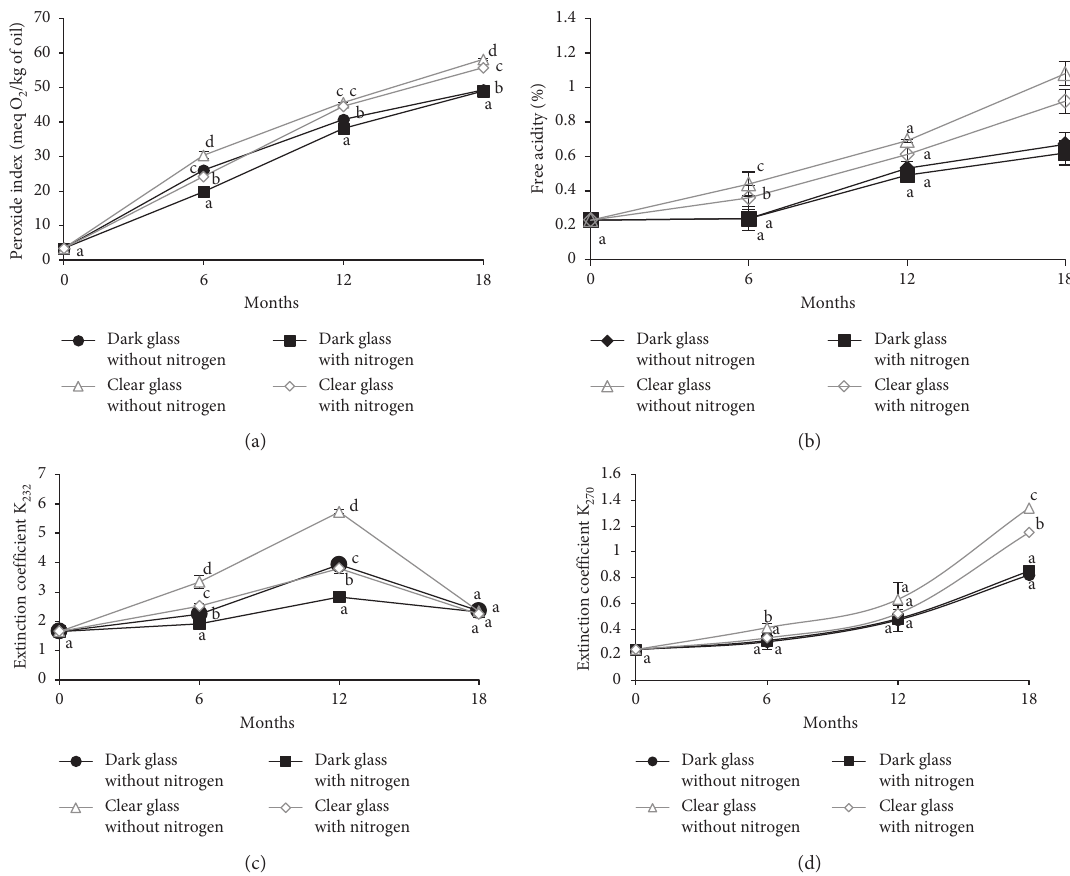
Figure 2: Evolution of quality parameters of prickly pear seeds oil during storage at various packaging conditions: dark glass bottles/clear glass bottles, with nitrogen/without nitrogen. (a) Peroxide index. (b) Free acidity. (c) Specific extinction coefficient K 232 . (d) Specific extinction coefficient K 270 . The error bars represent the standard deviation of three replicates. Means with the same letter for the same storage time are not significantly different according to Student–Newman–Keuls test at P <